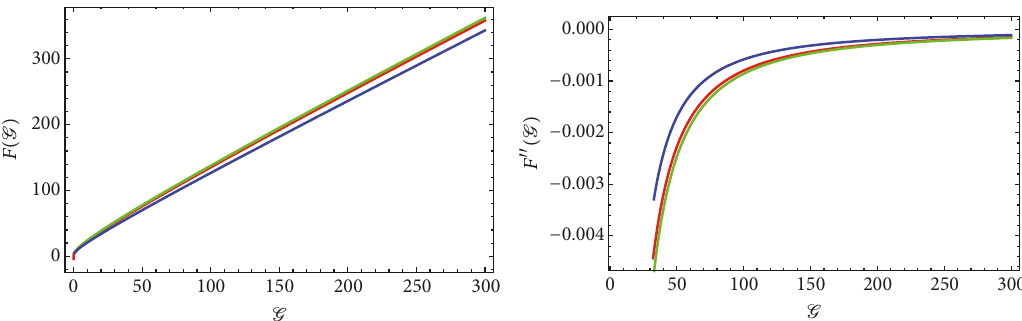
Figure 1: Evolution of holographic DE 𝐹( G ) model (left) and 𝐹 󸀠󸀠 ( G ) (right) versus G for 𝜆 = 1.5 (red), 𝜆 = 2 (green), and 𝜆 = 2.4 (blue).